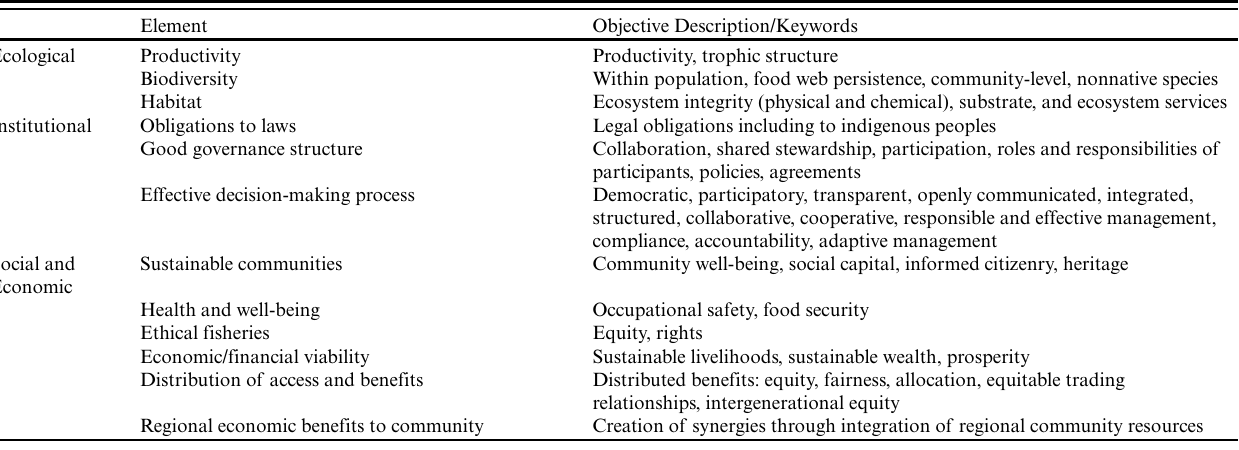
Table 1 . Canadian Fisheries Research Network (CFRN) fisheries sustainability framework detailed objectives and keywords (as presented in Stephenson et al. 2019 b ).